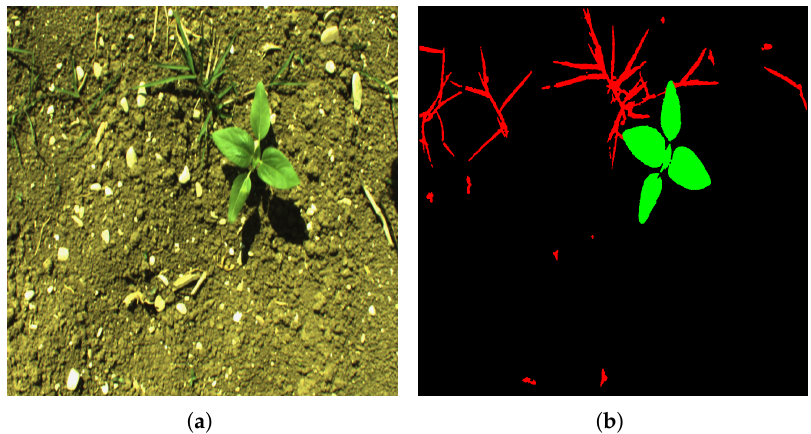
Figure 5. Example of an image found in the Sunflower dataset and its respective segmentation mask. ( a ) Image. ( b ) Segmentation mask.